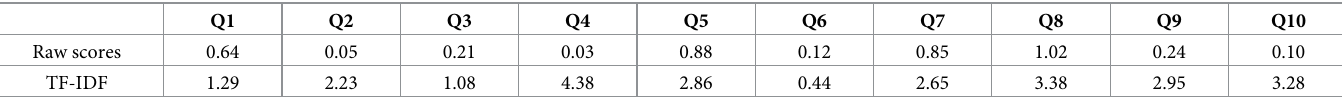
Table 5. KL divergence for JIS